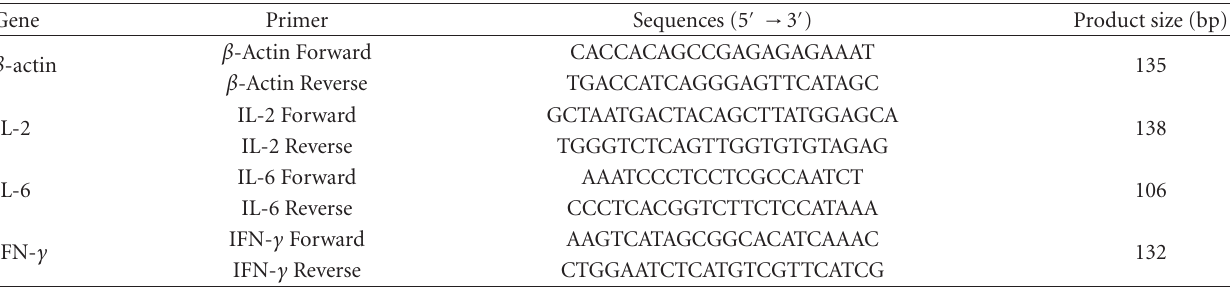
Table 1: Real-time PCR primer sequences and